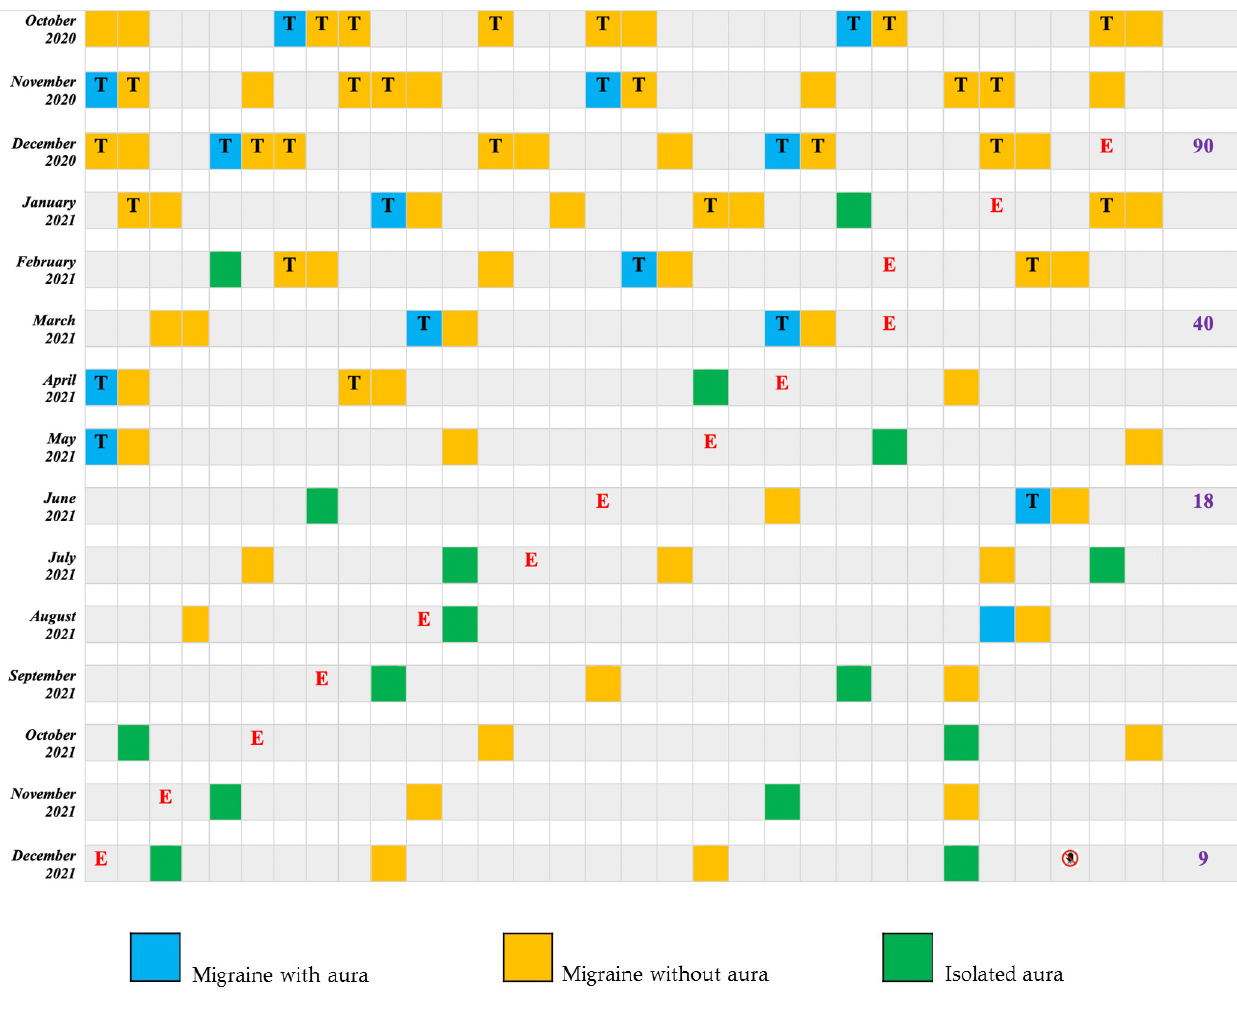
Figure 2. Patient 2 Migraine Diary. T: Triptans; E: Erenumab; MIDAS: Migraine Disability Assessment Test Score; 28 days after Erenumab discontinuation.